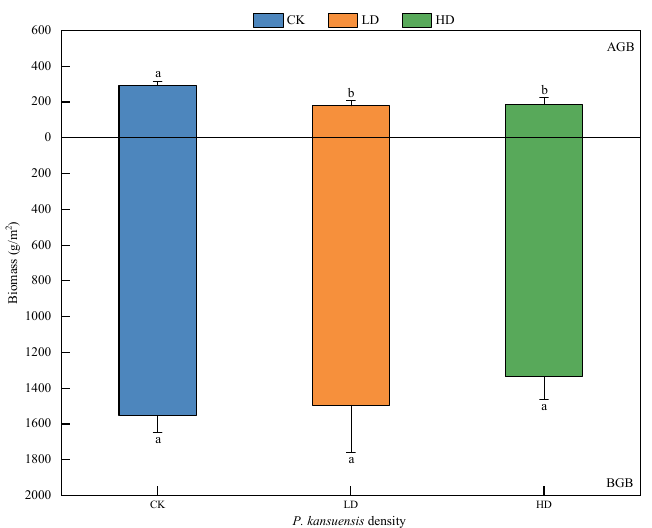
Figure 3. Community biomasses of P. kansuensis patches in different densities. AGB and BGB indicate aboveground biomass and belowground biomass, respectively. Various alphabetical characters depict significant differences among diverse density patches ( p < 0.05).